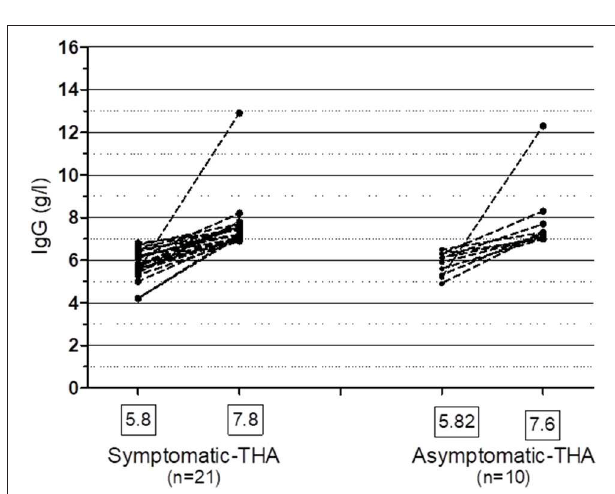
FIGURE 5 | Spontaneous recovery of IgG ≥ 7.0 g/l in patients with symptomatic and asymptomatic hypogammaglobulinemia on at least one occasion. One patient who was treated with IVIG, who recovered her IgG is included in the Symptomatic group. THA, transient hypogammaglobulinemia of adulthood. Mean IgG levels (g/l) are shown in the